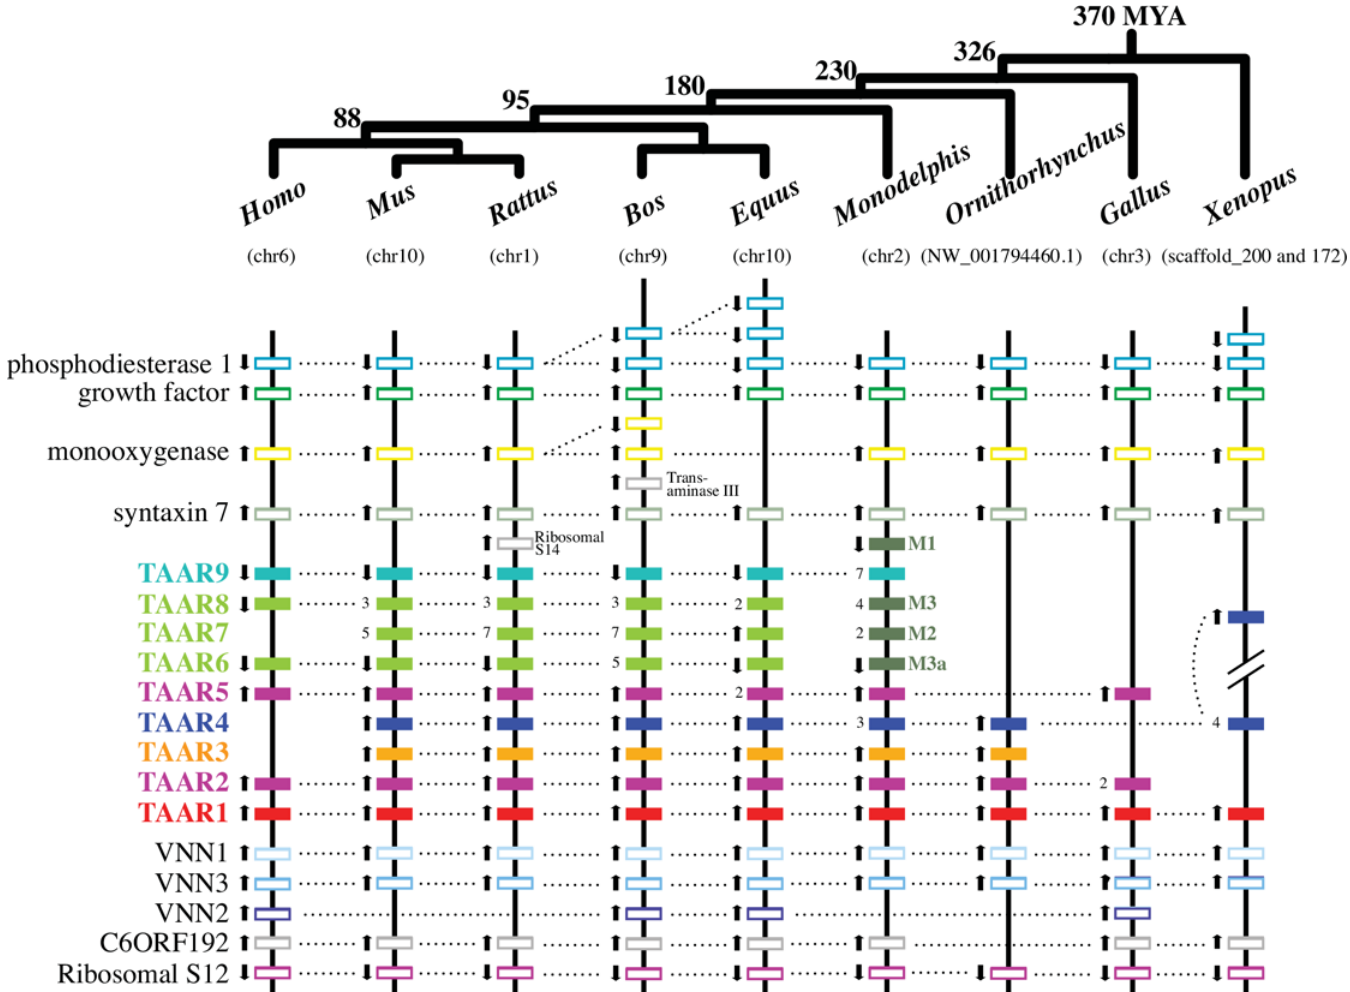
Fig 1. Syntenic relationship of the TAAR genes in nine vertebrate genomes. Only genomes in which all TAAR genes are located in one chromosome or no more than two scaffolds were examined ( Xenopus genes are found in two scaffolds). TAAR and adjacent non-TAAR genes are depicted by the closed and open boxes, respectively (pseudogenes are not included). TAAR genes are shown in different colors based on their taxonomic distributions as follows: TAAR1 found in jawed vertebrates in red, amniote-specific TAAR2 and TAAR5 in purple, mammalian-specific TAAR3 in orange, tetrapod-specific TAAR4 in dark blue, eutherian-specific TAAR6, 7, and 8 in light green, therian-specific TAAR9 in cyan, and metatherian-specific TAARM1-M3 in dark green. Note that the same color scheme is used in Figs 2 and 3. When tandemly duplicated functional copies exist for a TAAR gene, the copy number is also shown. Gene locations are not in scale (see S2 Table for the actual positional information). Black arrows indicate transcriptional directions. A current consensus of the tetrapod phylogeny with their approximate divergence times (million years ago; MYA) is illustrated at the top [33, 34]. The chromosome or scaffold numbers are shown below the genus